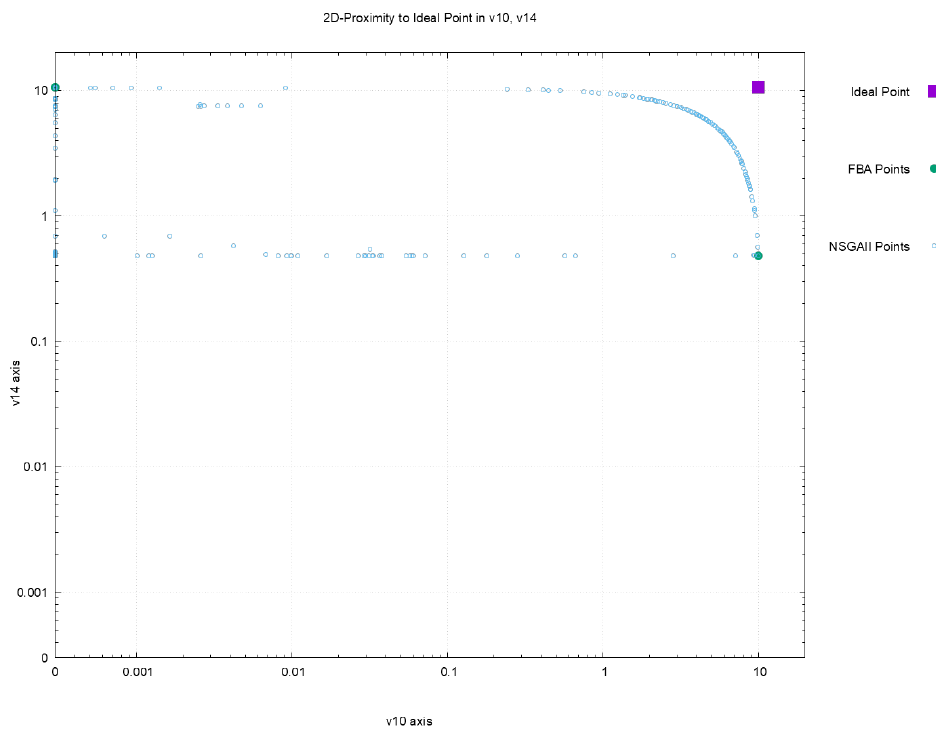
Figure 3. Pareto approximation for configuration C 0 with respect to the plane formed by objectives ( v ) . 10 , v 14